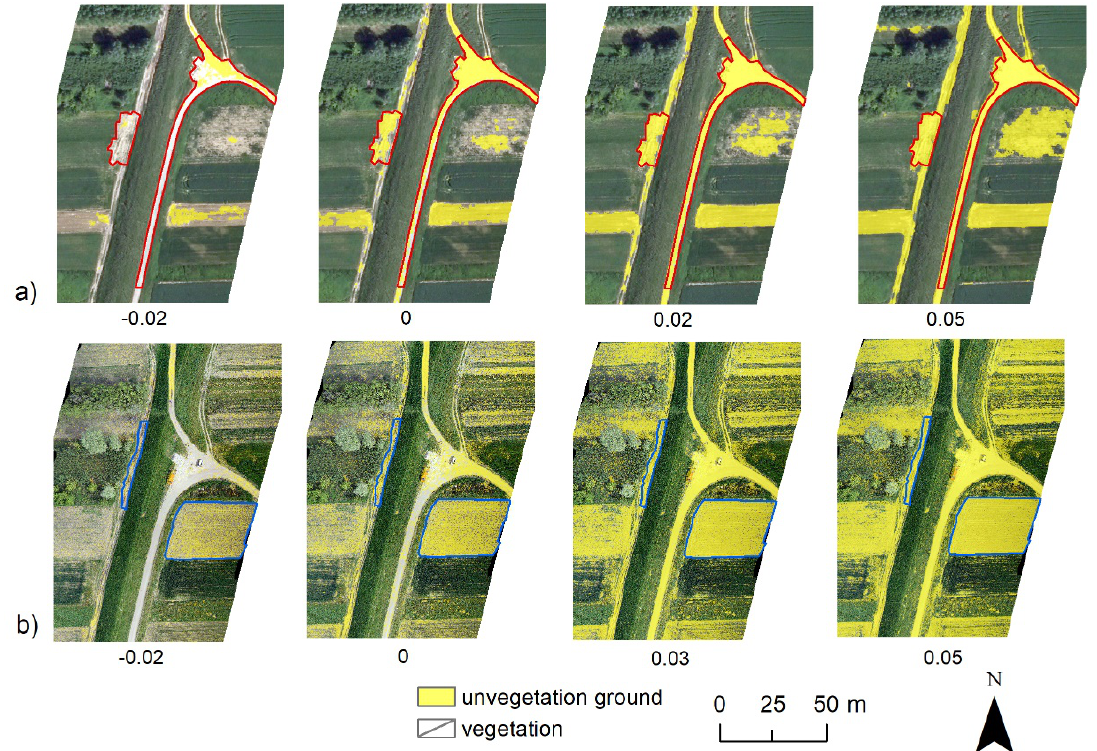
Figure 8. Visualisation of selected GRVI thresholds calculated from aerial ( a ) and UAS ( b ) images.